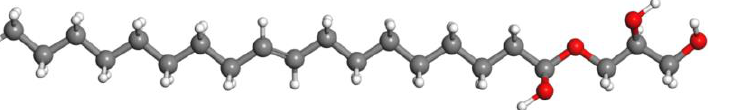
Figure 1. Schematic GMO molecule structure, with the gray, red and white spheres representing carbon, oxygen and hydrogen atoms respectively.